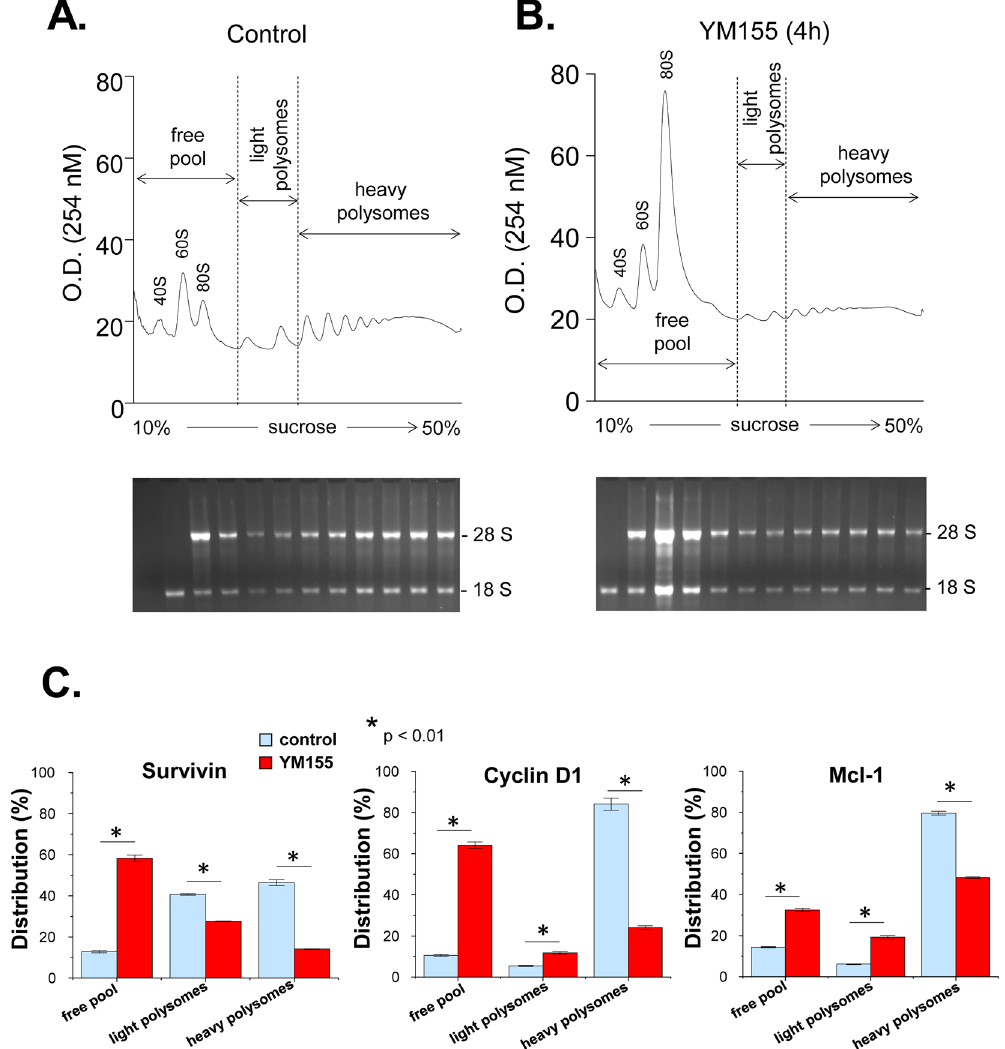
Figure 7. Polysome profile analysis of cells treated with YM155. ( A , B ) PC3 cells were treated with DMSO ( A ) or 100 nM YM155 ( B ) for 4 h, and were subjected to the polysome profile analysis. RNA was isolated from each fraction and was visualized via Ethidium bromide-stained agarose gel. ( C ) The association of survivin, cyclin D1, and Mcl-1 mRNAs with the free pool of mRNPs and monosomes, the light polysomes (2- and 3-ribosomes) and the heavy polysomes ( > 3-ribosomes) were determined by quantitative